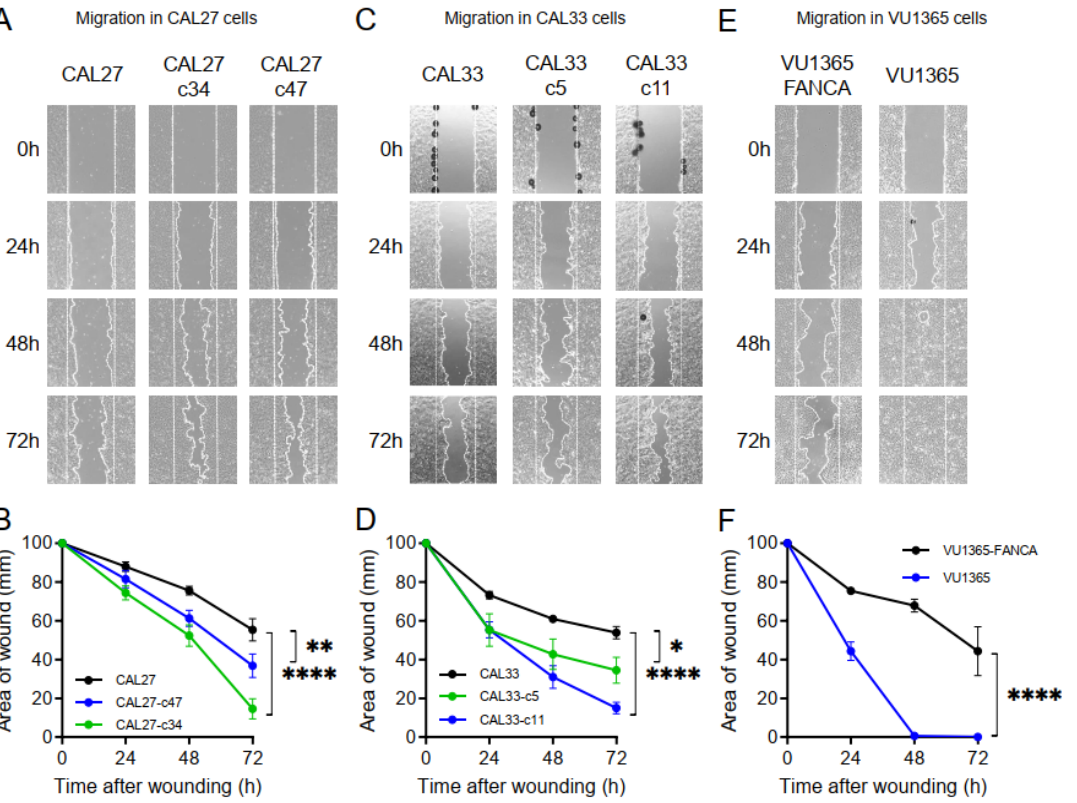
Figure 5. Migration analysis of FANCA -edited cells. ( A , C , E ): Representative images of keratinocyte sheets that were scratch wounded to assess migration. Scale bar: 100 µ m. ( B , D , F ): Wound area analyzed at different times after wounding at 1% FBS. Data are mean ± SEM of one experiment with four images per time-point. p -values were calculated upon a two-way ANOVA test. *: p -value ≤ 0.05; **: p -value ≤ 0.01; ****: p -value ≤ 0.0001. CAL27 and CAL33 edited clones as well as VU1365 cells migrated faster as they closed the wounds earlier.